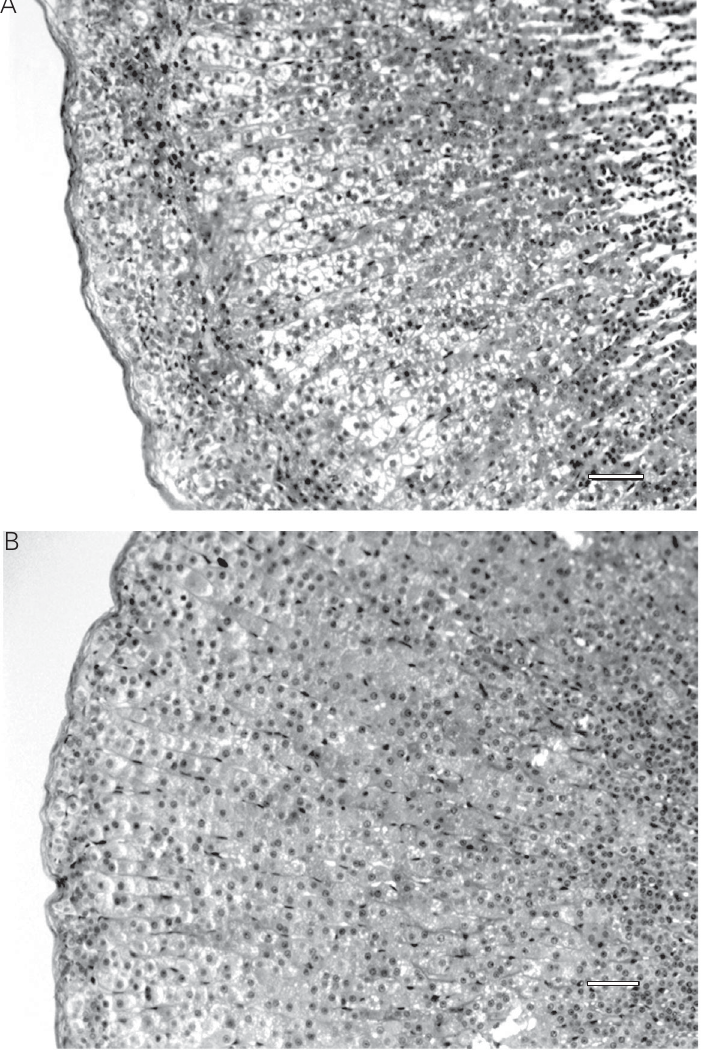
Figure 1 - Effect of domperidone administration on the zona fasciculata of rat adrenal glands. The rats were treated with 4.0 mg/kg domperidone sc for 60 days. The large number of vacuoles in the untreated control (A) was reduced by domperidone treatment (B). Bar = 10.28